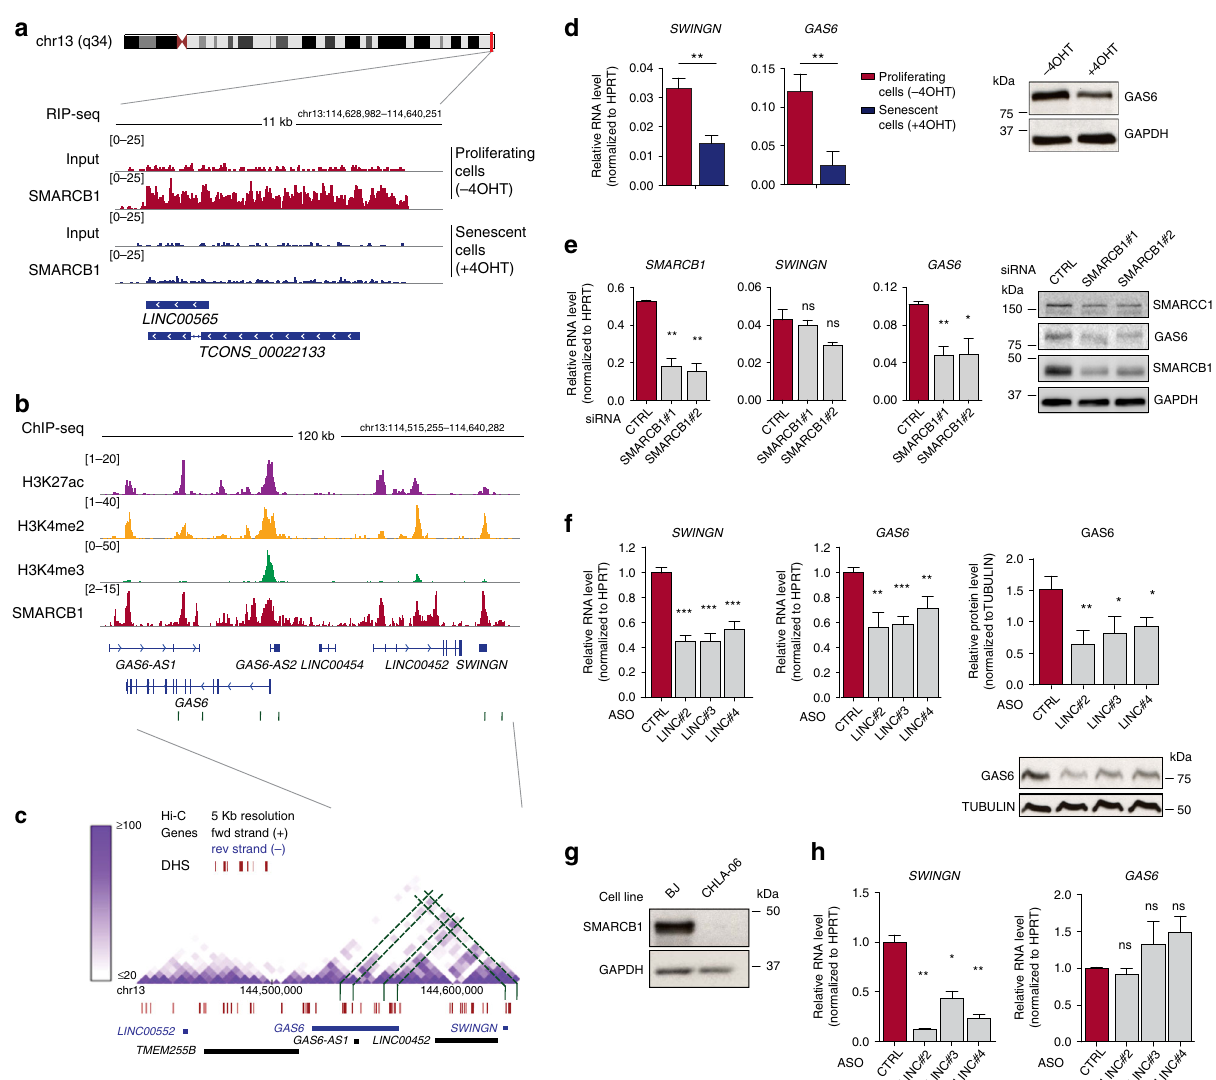
Fig. 3 SWINGN lncRNA controls the expression of its neighbor gene through SMARCB1 as part of a chromatin domain. a Genomic snapshot of SMARCB1 and Input RIP-seq signal at SWINGN locus in proliferating ( − 4OHT; red-colored) and senescent ( + 4OHT; blue-colored) BJ cells. b SMARCB1 and histone marks ChIP-seq signal at SWINGN / GAS6 locus in proliferating BJ fi broblasts. Gray boxes indicate SMARCB1 peaks. c High-resolution Hi-C analysis of proliferating IMR90 fi broblasts at SWINGN / GAS6 locus 37 . Green lines highlight regions of stronger chromatin interaction. Red segments indicate DNAse Hypersensitivity Sites (DHS). Gray box highlights the region depicted in b . Data are downloaded from http://promoter.bx.psu.edu. d RT- qPCR (left) and western blot analyses (right) of proliferating ( − 4OHT) and senescent ( + 4OHT) BJ fi broblasts. Graph shows mean ± SD of three independent experiments (left). Western blot picture refers to a representative experiment ( n = 2). e RT-qPCR (left) and western blot analyses (right) of BJ proliferating cells depleted or not of SMARCB1 by siRNA double transfection. Graph shows mean ± SD of independent experiments. Western blot picture refers to a representative experiment ( n = 2). f (Left) RT-qPCR analysis of BJ fi broblasts depleted of SWINGN using three different ASOs. Graphs show mean ± SEM of normalized values from n = 3. RNA levels were normalized to ASO_CTRL values. (Right) Western blot analysis of BJ cells depleted of SWINGN . Mean± SD of three independent experiments. Western blot image of a representative experiment. g Western blot analysis of BJ fi broblasts and CHLA-06 AT/RT cells. GAPDH was used as loading control. h RT-qPCR analysis of CHLA-06 cells depleted of SWINGN using three different ASOs. Graphs show mean ± SD of two independent experiments. RNA levels were normalized to ASO_CTRL values. Source data underlying panels d – h are provided as a Source Data fi le. Signi fi cance was determined by two-tailed Student ’ s t -test and summarized as follows: not signi fi cant (ns); * < 0.05; ** < 0.01; *** <